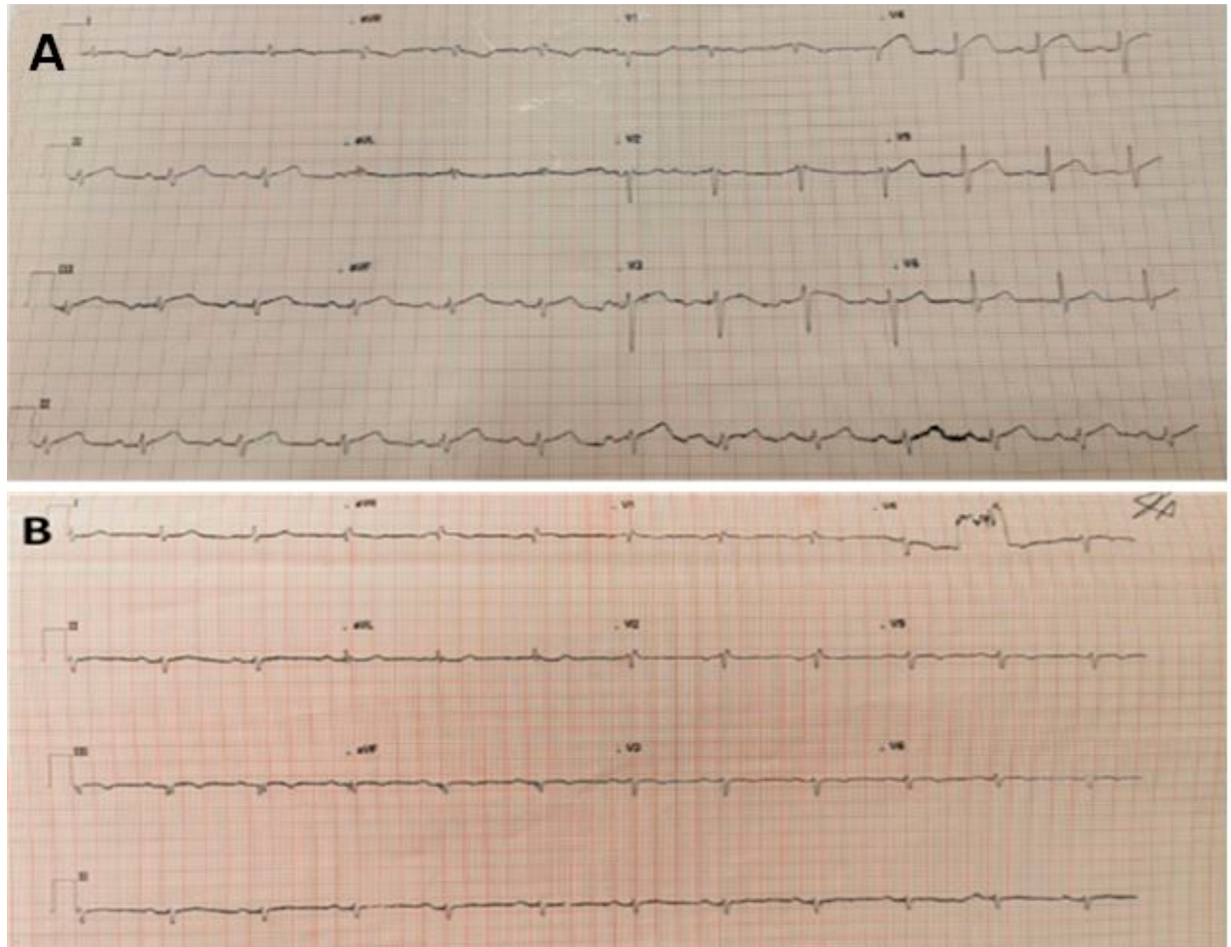
Figure 1. ( A ) 12-lead ECG taken on first admission. Sinus rhythm with ST segment elevation in chest leads V3-4 and limb lead II. Heart Rate 74, PR 210 ms, QRS 109 ms, QT/QTc 408/436 ms. ( B ) 12-lead ECG taken on second admission to A and E, which outlined sinus rhythm with right bundle branch block and T wave inversion from V3 to V6; VR 69, PR interval 185 ms, QRS 118 ms, QT/QTcinter- val—384/403 ms.